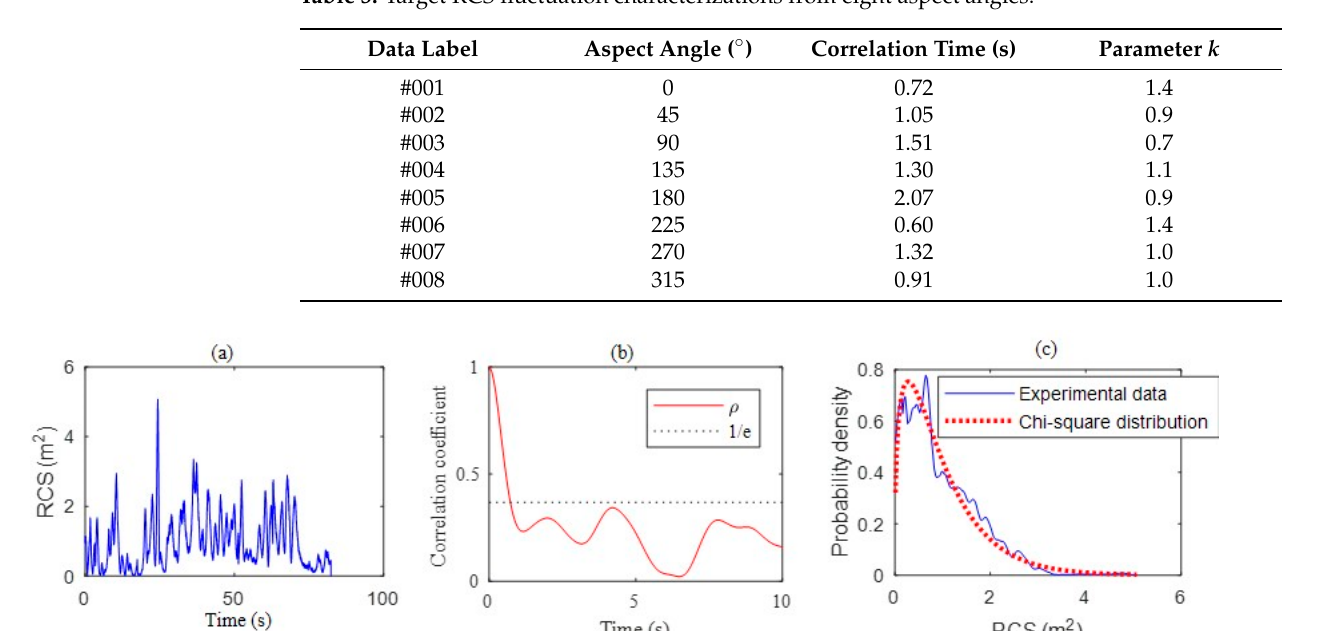
Figure 4. Target RCS fluctuation characteristic from data #001 at an aspect angle of 0°. ( a ) Time-RCS sequence; ( b ) time correlation; ( c ) probability distribution.